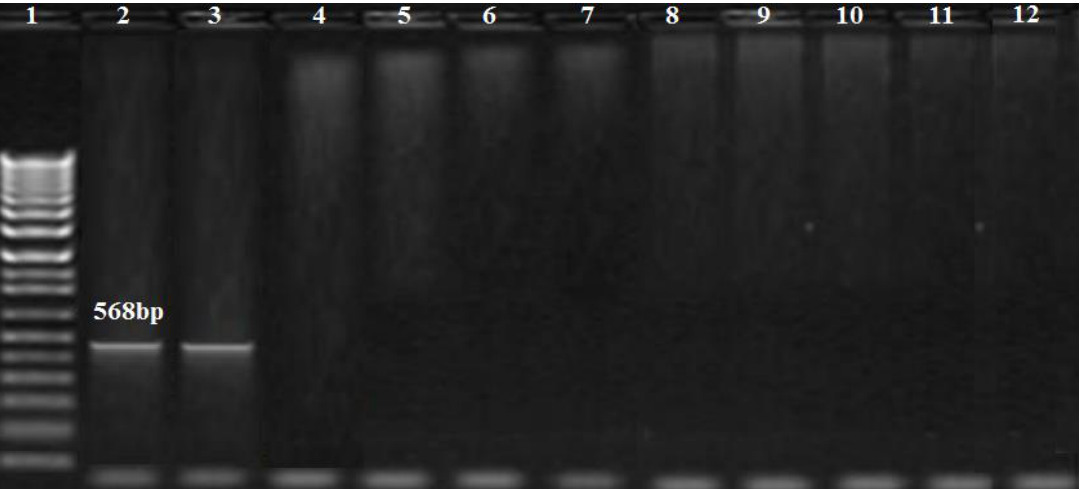
Figure 4. Amplification profile of the bla IMP gene (568 bp). Lane 1: DNA marker (100 bp Biolabs Company, Cat.N3231S, England); lane 2: positive control; lane 3: positive for the bla IMP gene; lane 12: negative control.